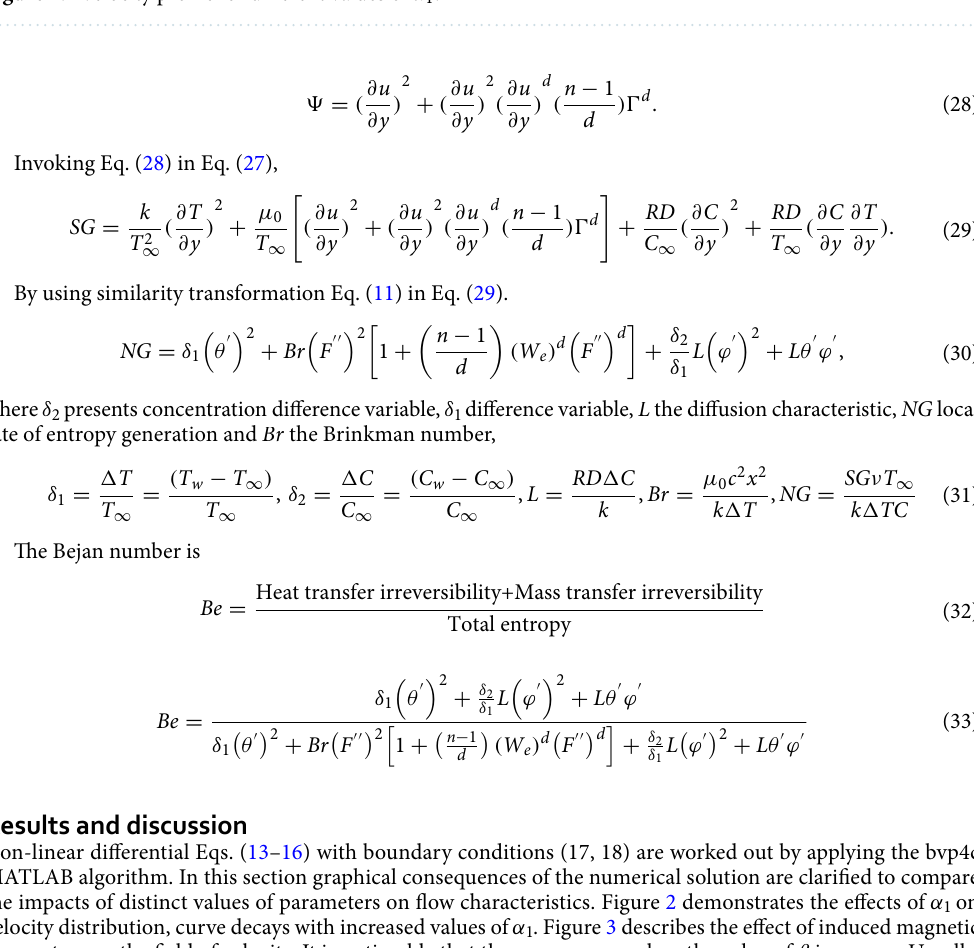
Figure 2. Velocity profile for different values of α 1